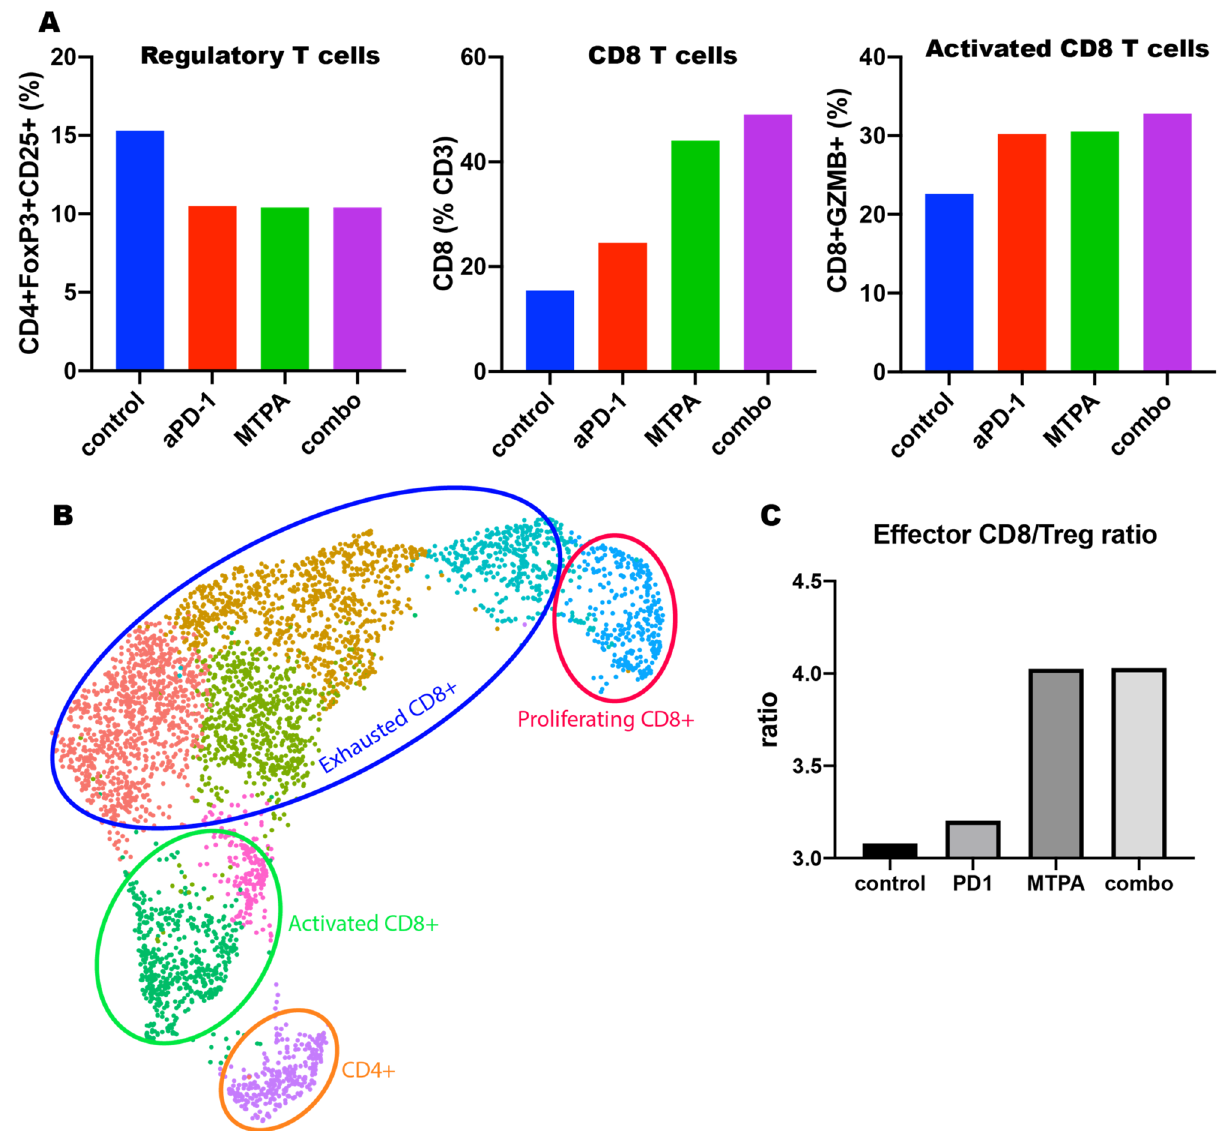
Figure 5. MTPA augments tumor immunity. MTPA +/− anti-PD-1 therapy was performed in an orthotopic mouse model with underlying cirrhosis. A, flow cytometry demonstrated an increase in the overall CD8 T cell population as well as activated effector CD8 T cells within the tumors treated with MTPA and combination therapy; there was also a concomitant decrease in the T reg population in these tumors. B, C, These findings were confirmed on scRNAseq of intratumoral T cells highlighted a significant increase in the ratio of activated effector CD8+ T cells to immunosuppressive T regs with MTPA but not with anti-PD-1